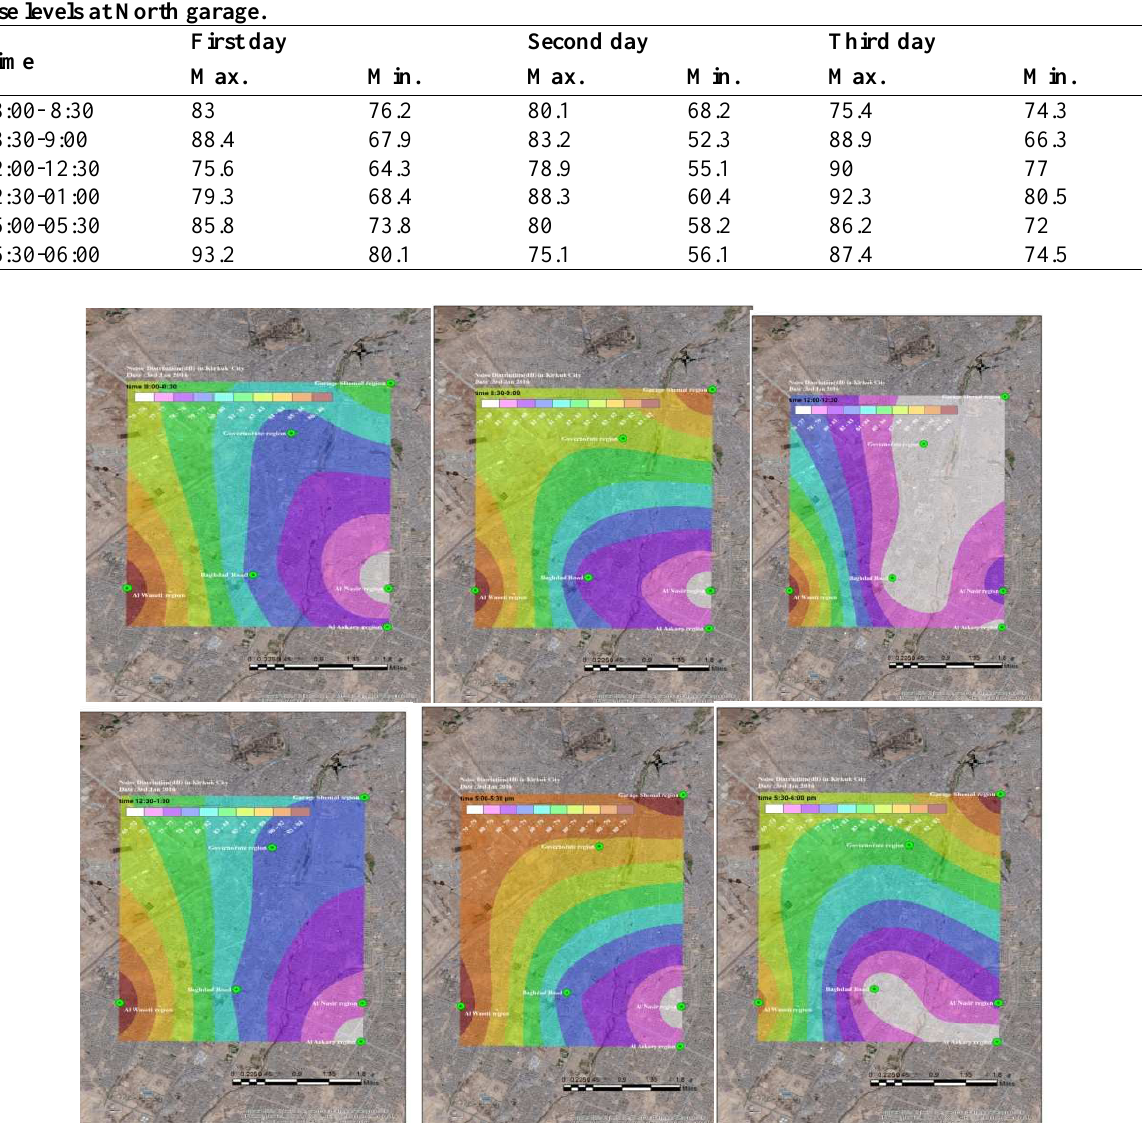
Last site was North garage which considers as an industrial area and has heavy hourly traffic volume from Kirkuk to the governorates of the north of Iraq. The maximum pollution levels values were 93.2 dB(A) as shown below in table (10) which is higher than limited values in Table2. Table 10, Noise levels at North garage. Time